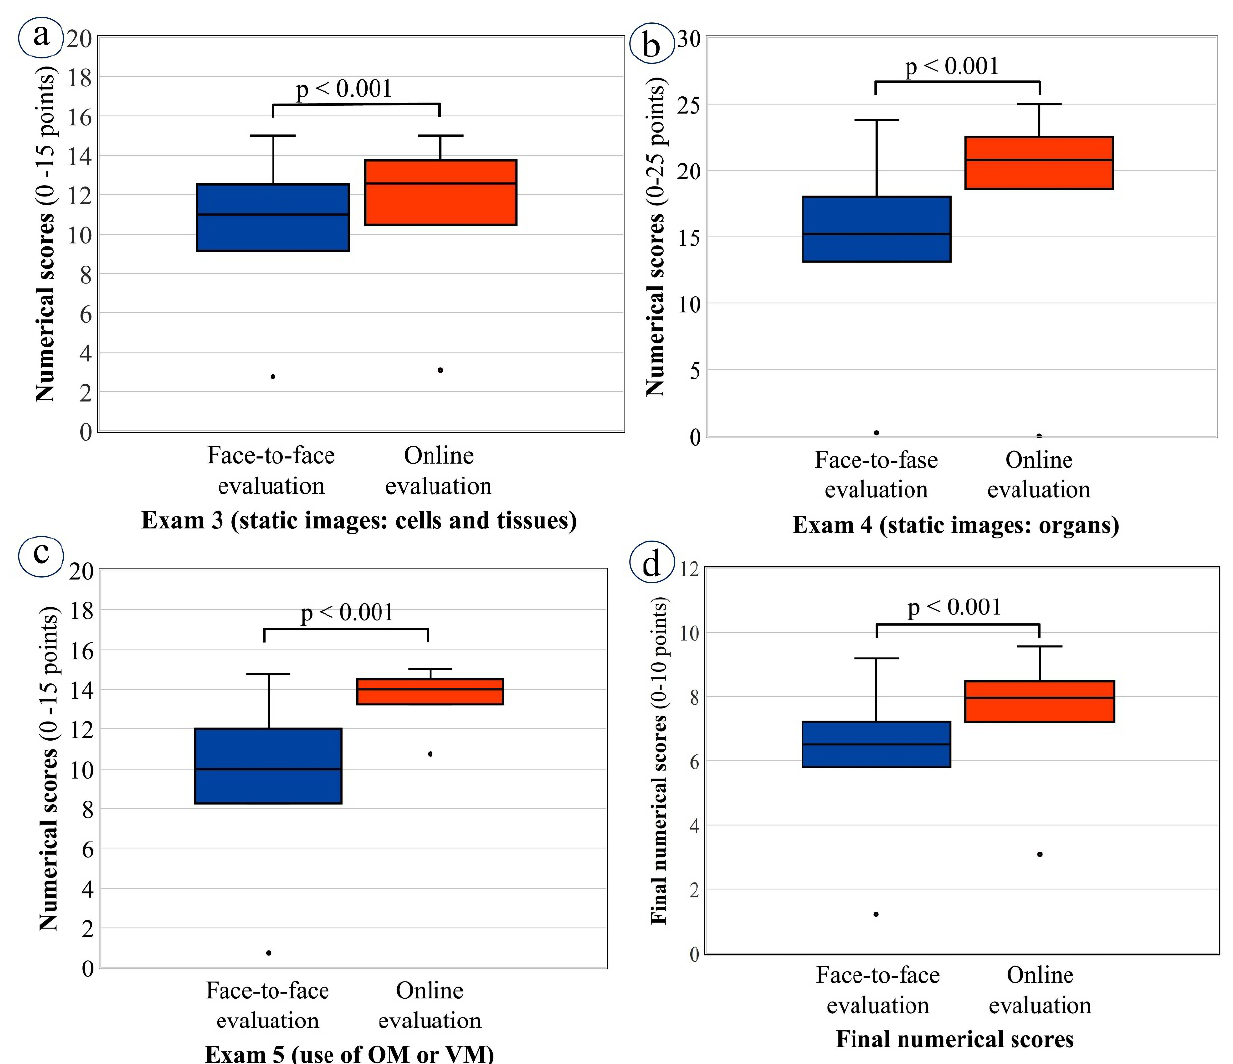
Figure 6. Box plots of median and interquartile range (IQR) of numerical scores achieved by students in theoretical exams (exams 1 and 2): face-to-face (2018–2019) and online (2019–2020) cohorts compared. ( a ) Exam 3 on the identification of cells and tissues with use of static images: face-to-face (median = 11.00; IQR = 9.13–12.50) versus online (median = 12.55; IQR = 10.49–13.75) evaluation; ( b ) Exam 4 on the identification of organs using static images: face-to-face (median = 15.25; IQR = 13.13–18.00) versus online (median = 20.80; IQR = 18.59–22.50) evaluation; ( c ) Exam 5: the identification and description of organs using either optical microscopy (median =10; IQR = 8.25–12.00) or virtual microscopy (median = 14.00; IQR = 13.25–14.50); ( d ) Final numerical scores in CH: face-to-face (median = 6.50; IQR = 5.80–7.20) versus online (median = 7.96; IQR = 7.19–8.47) evaluation. Non-parametric Mann–Whitney U test was applied for statistical analysis. OM, optical microscopy; VM, virtual microscopy.